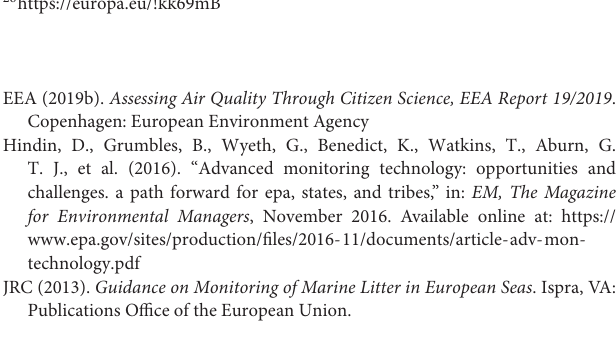
Supplementary Figure 1 | Number of observations registered in the Estonian Nature Observations Database over the last 10 years. Supplementary Figure 2 | Comparison of the top ten items of litter collected by the regional sea beaches between 2014 and 2019 (Kideys and Aydin, 2020b). 26